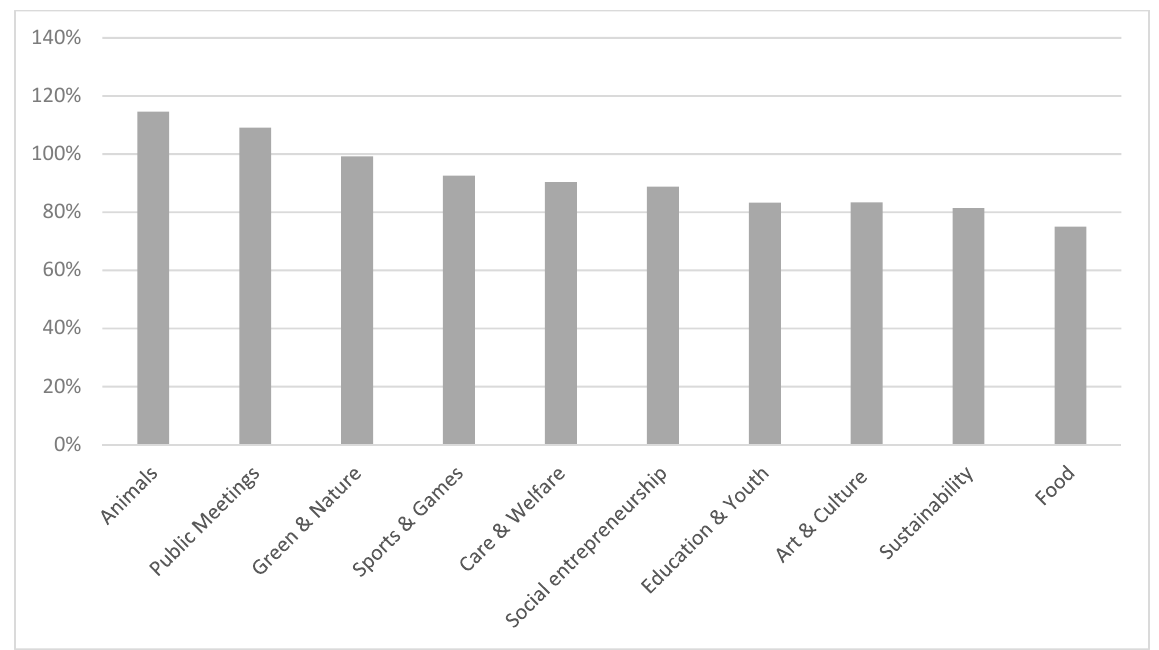
Figure 2. Average success ratios of civic crowdfunding projects, i.e., ratios of realized earnings and target earnings, per project theme (vertical axis: average success ratio per project theme; horizontal axis: project theme).